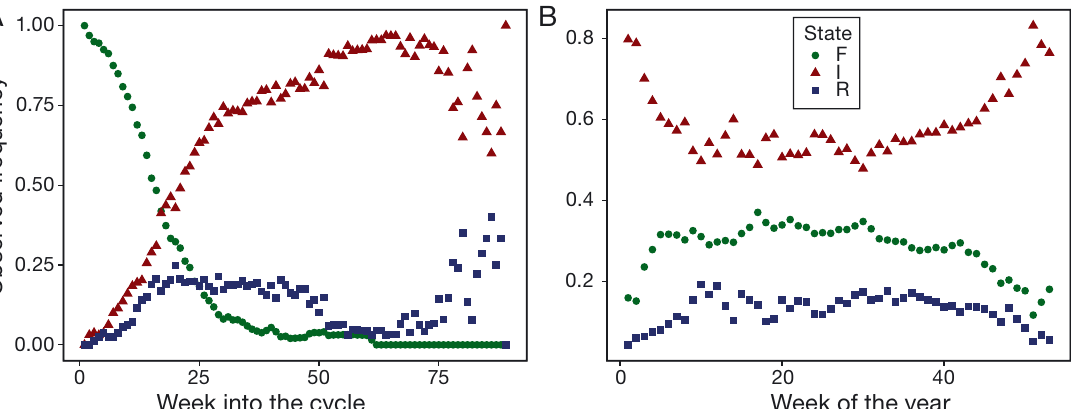
Fig. 5. Observed piscirickettsiosis disease dynamics at salmon farms in the Los Lagos region, by (A) week of the production cycle and (B) week of the year. Disease state: F : disease-free; I : infected; R : recovered